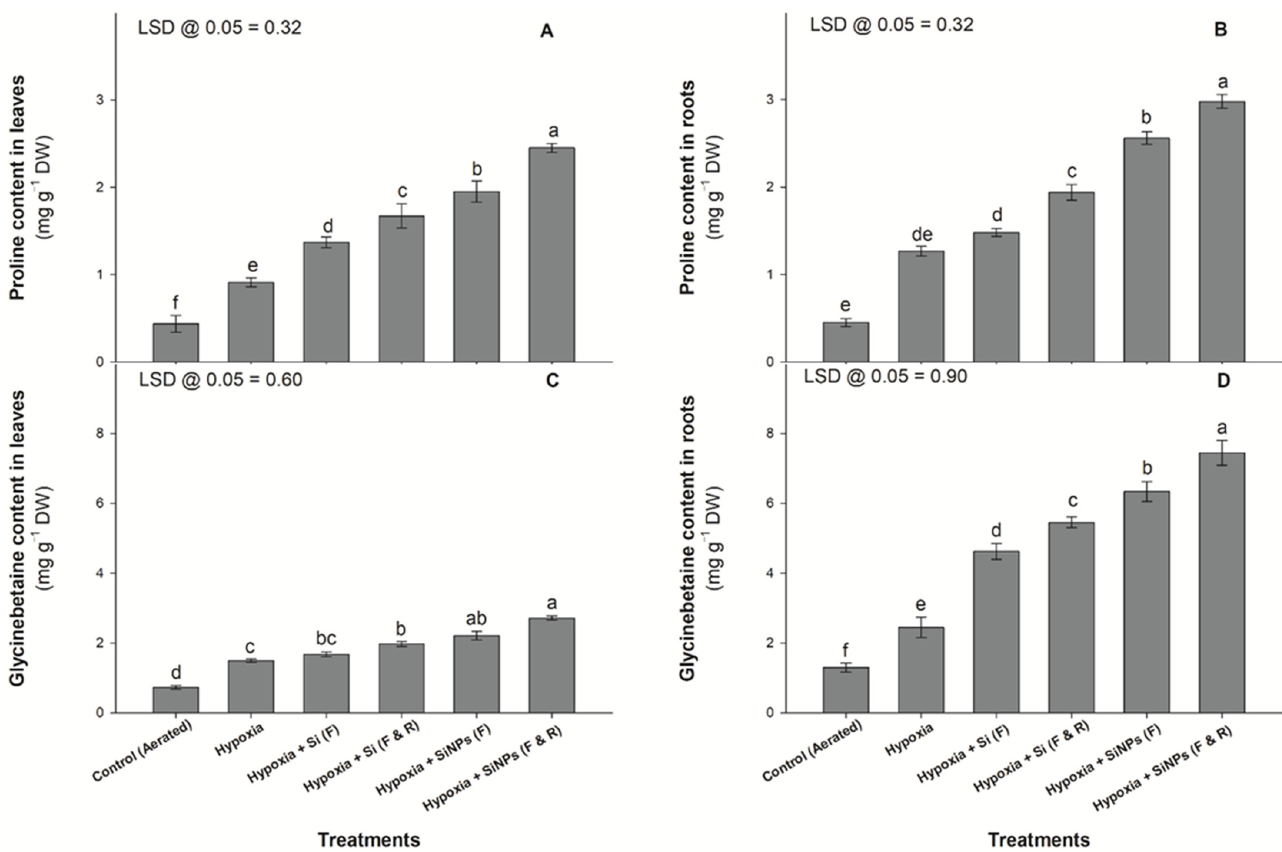
Figure 6. Proline ( A , B ), and glycinebetaine ( C , D ) content in leaves and roots of blueberry plants in response to six treatments i.e., (i) control (aerated), (ii) hypoxia, (iii) hypoxia + Si (F), (iv) hypoxia + Si (F & R), (v) hypoxia + SiNP (F), (vi) hypoxia + SiNPs (F & R). Values are mean of four independent replicates ( n = 4) ± SE (shown in vertical bars), and values denoted by different letters (in small alphabets) differ significantly at p < 0.05, using the LSD test. The abbreviations used are F: foliar application of Si or SiNP; F & R: combined foliar and root zone application of Si; R: root zone application of Si or SiNP; Si: conventional silicon; SiNPs: silicon nanoparticles.